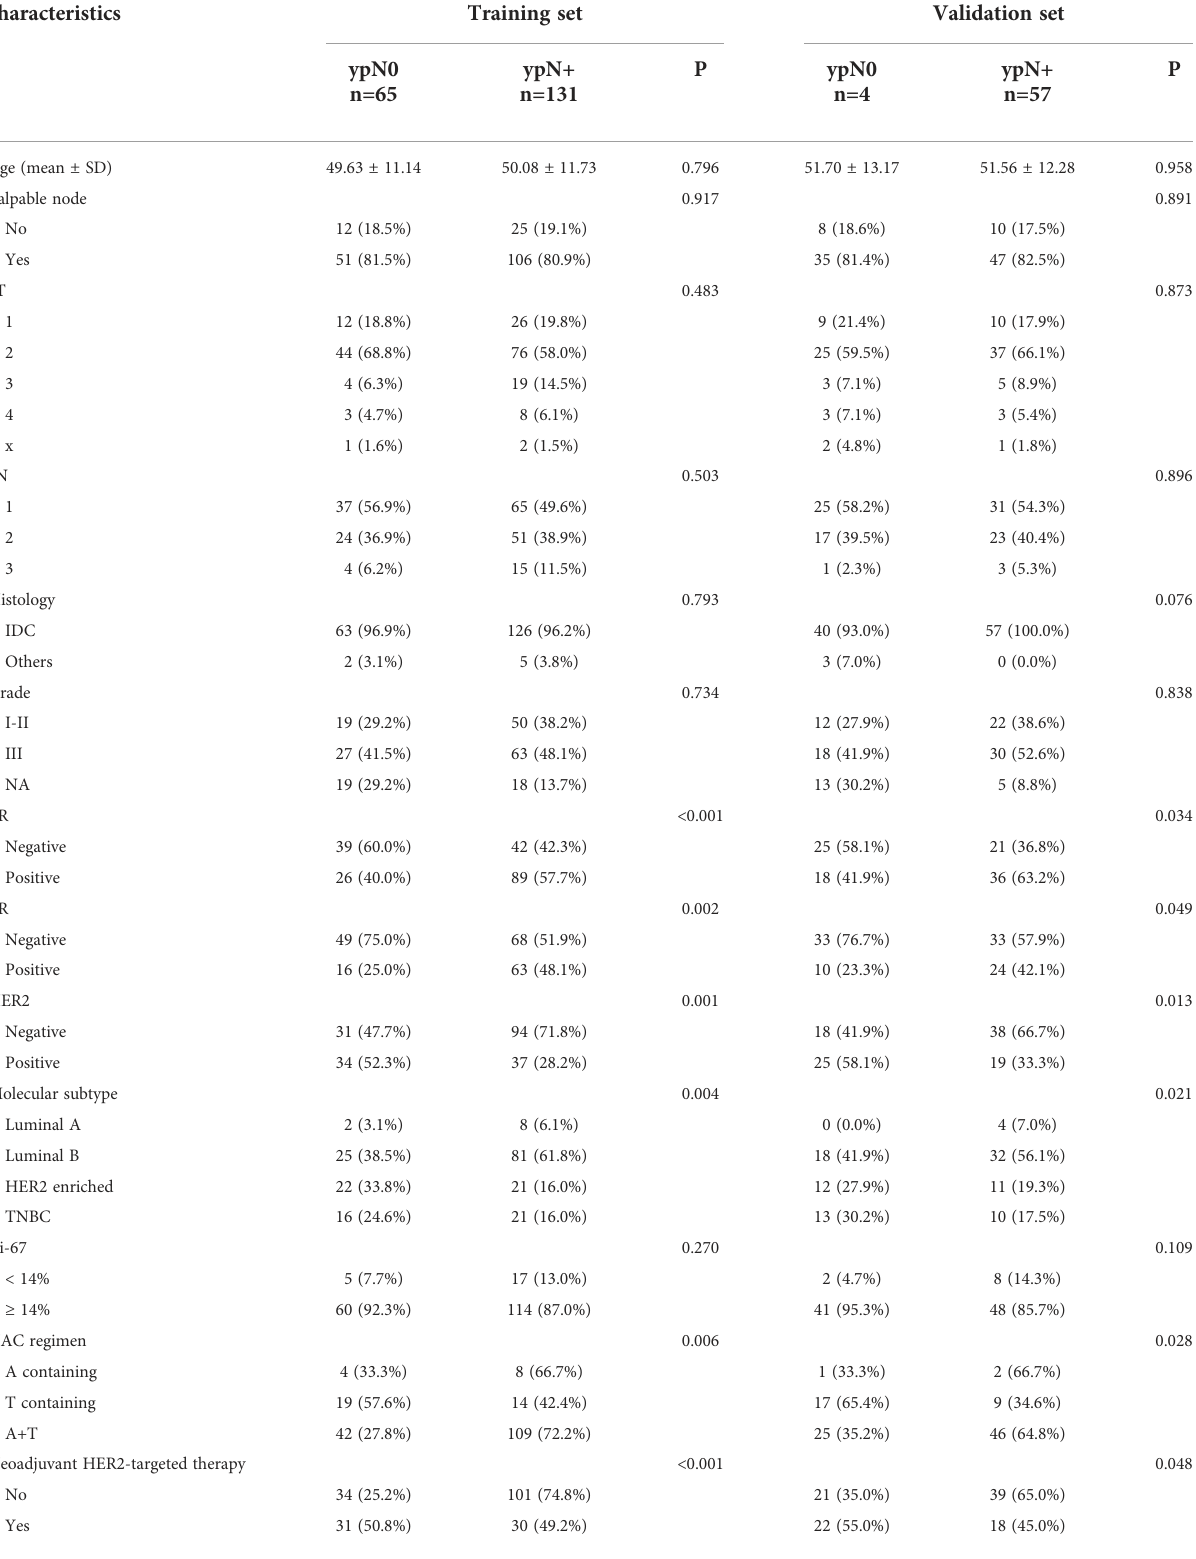
TABLE 1 Baseline characteristics for the training set and the validation